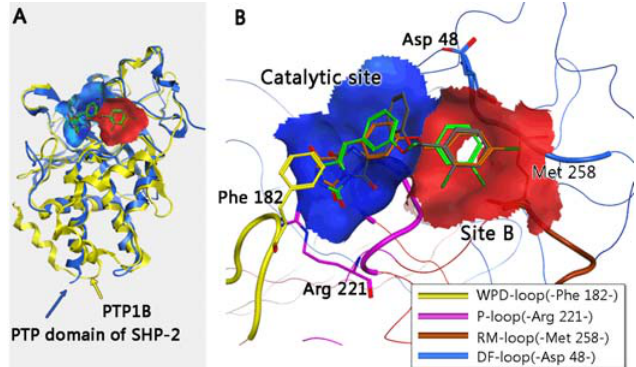
Figure 1. ( A ) The conformational superimposition of proteins encoding the Protein tyrosine phosphatase 1B (PTP1B) and protein tyrosine phosphatase (PTP) domain of SHP-2 with novel ligands and ( B ) the surface map of PTP1B within a 4 Å radius designed around the molecules. The blue surface indicates the catalytic site of the two proteins, while the area colored in red represents site B of PTP1B. Ligands with grey, green and orange colored carbon atoms represent Compounds 13 , 15 and 20 ,